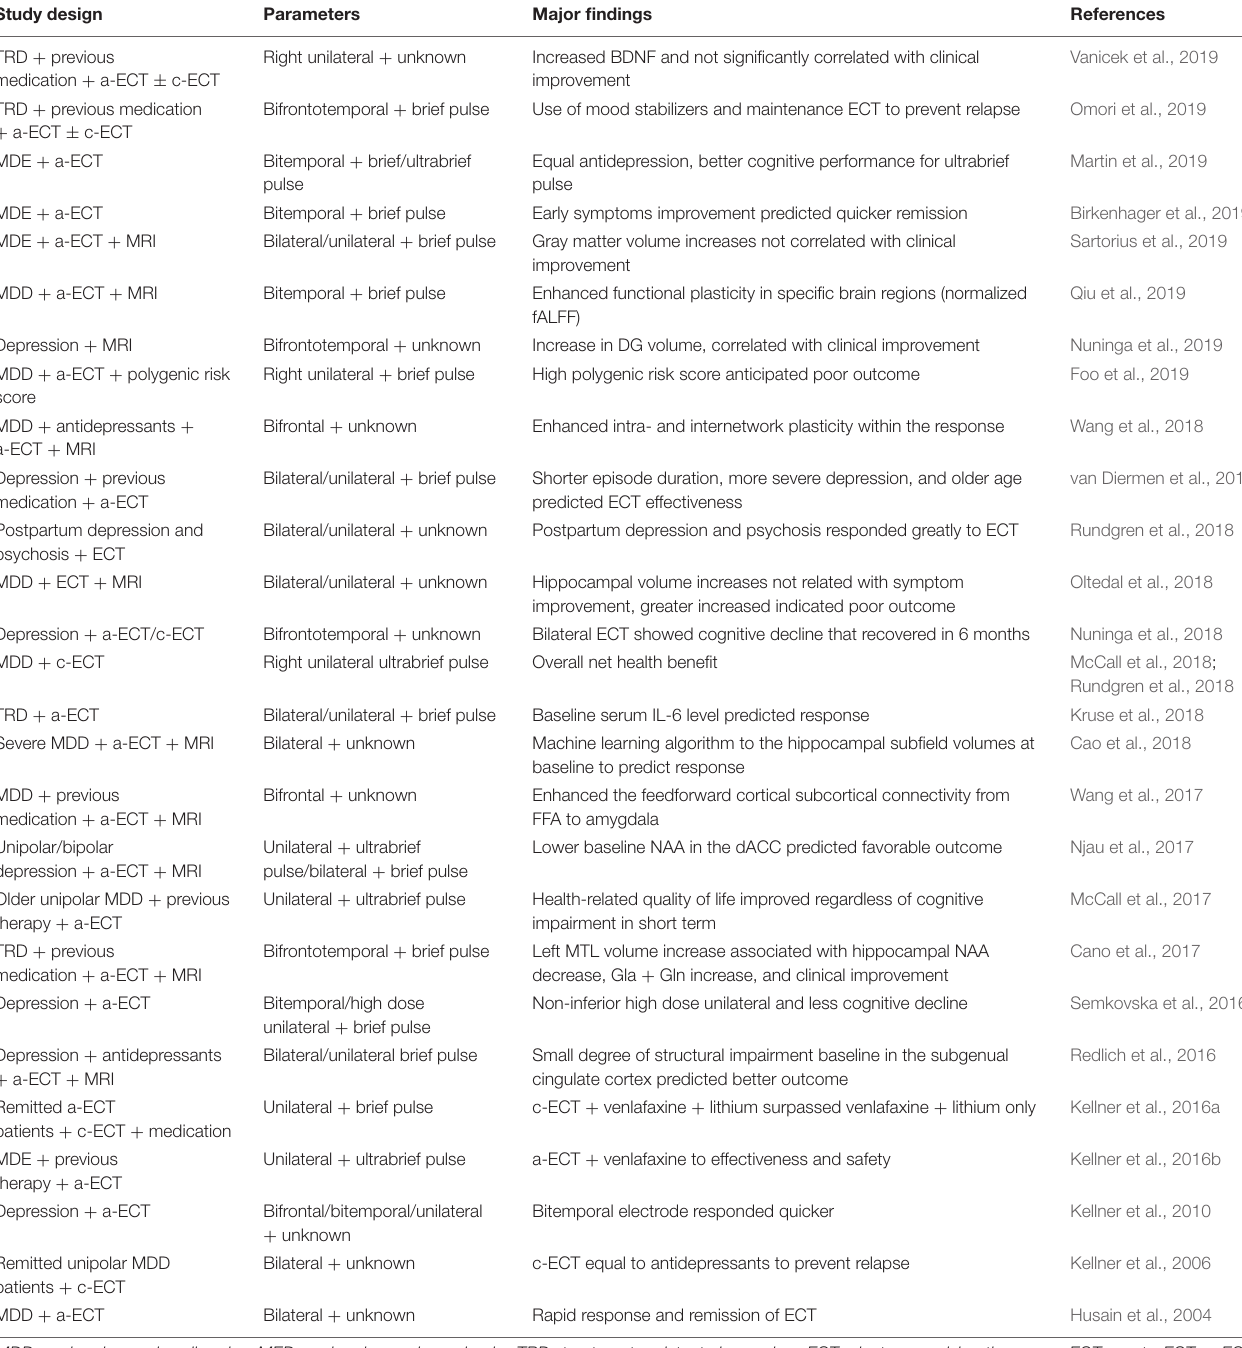
TABLE 1 | Summary of major ECT clinical